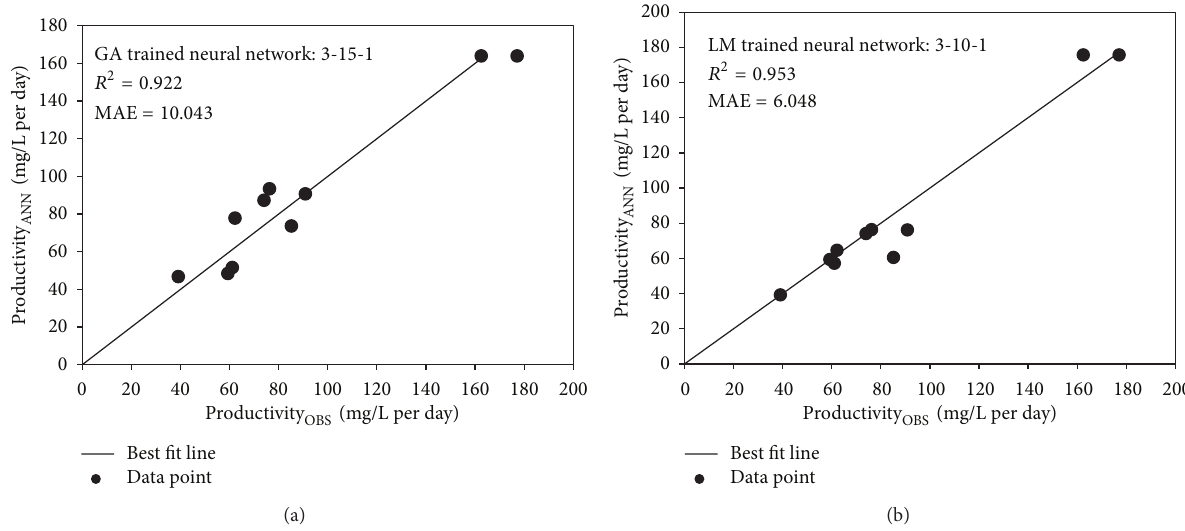
a set of inputs, Gaussian behaves like a probabilistic output controller, producing output that can be described as a type of partial response. This transfer function tends to map pattern quicker than sigmoid; nevertheless, its prediction can be prone to memorization.